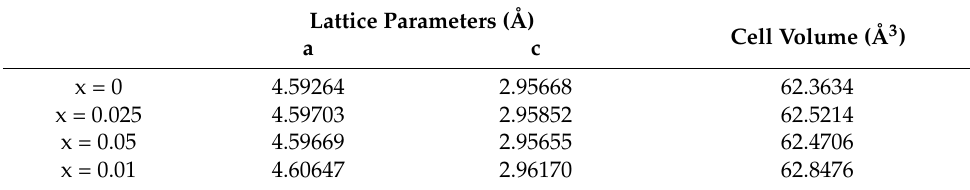
Figure 1. The XRD patterns of the sintered NSTO ceramics. Table 1. Lattice parameters and volume cell for NSTO